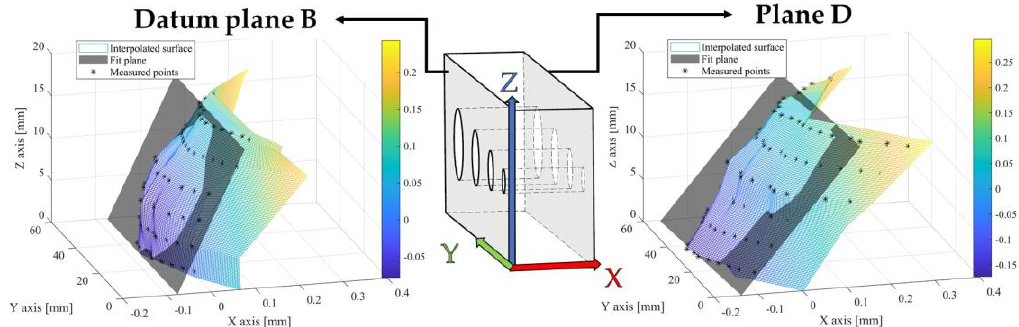
Figure 12. Sample 90°, points measured at the sintered state and reconstruction of the plane. Figure 13. Analysis of the shape distortion of datum plane B and plane D of the sintered sample 90°.